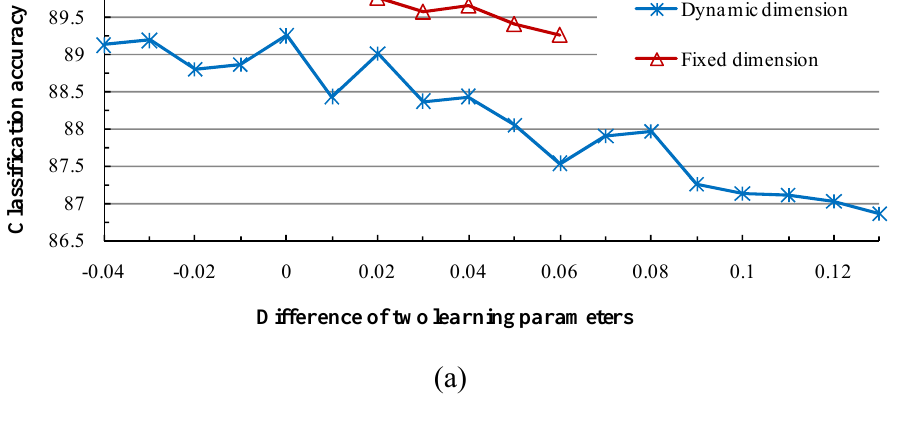
Difference of two learning parameters